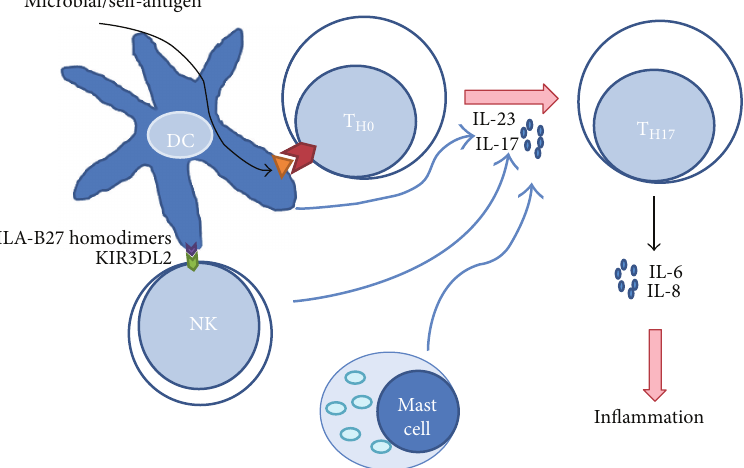
Figure 2: Possible role of Th17 in AS: dendritic cells (DC) could present an arthritogenic peptide derived from microbial pathogens or self- cells.ThedifferentiationoftheseTcellscouldbeinfluencedbyIL-17secretedbyNKcellsthatrecognizeHLA-B27homodimers antigenstoT H 0 cells that are involved in inflammation by molecules secreted, such as IL-6 and and mast cells to induce the differentiation to T H 17